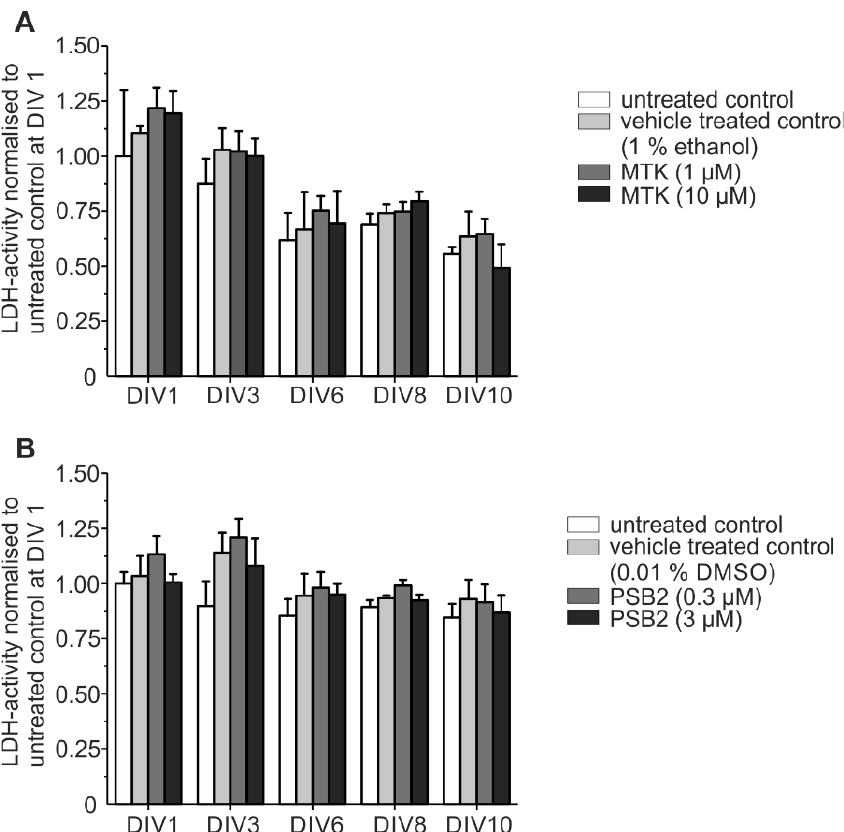
Figure 6. Toxicity testing. ( A ) LDH activity was measured after treatment with MTK ( A ) and PSB-16484 (PSB2) ( B ) compared to vehicle treated control und untreated control. Data have been normalized to the control value at DIV 1 of the respective preparation. Statistical analysis was performed using repeated measurement two-way ANOVA. Each sample represents incubation medium (IM) of one animal. The number of animals was n = 5.